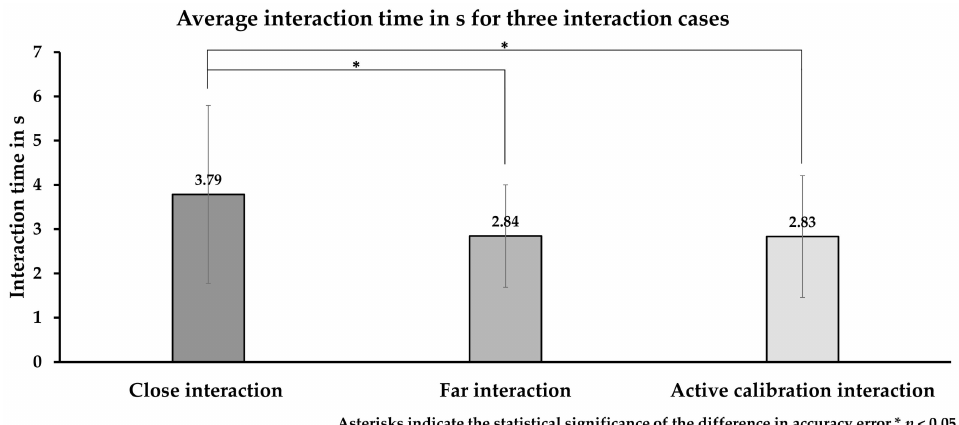
Figure 13. Interaction time for close, far, and active calibration interaction